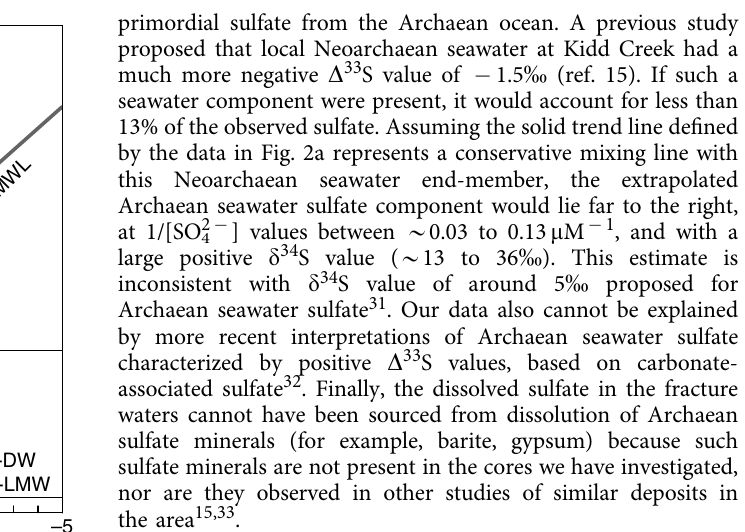
measured D 36 S values, the estimated slope of (cid:3) 1.1 is close to the value characteristic of sulfides in Archaean rocks (approximately (cid:3) 0.9; ref. 24) but statistically distinct from the canonical (cid:3) 7 (refs 28,29; Fig. 2b). The presence of sizable S-MIF in 36 S/ 32 S values rules out the magnetic isotope effect associated with